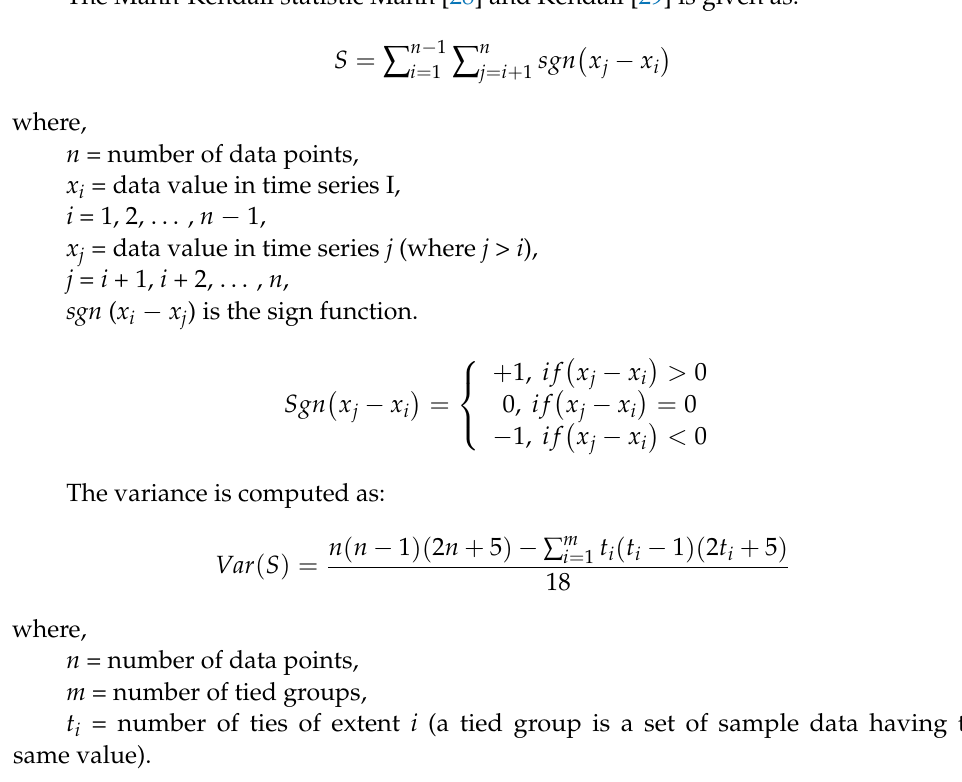
Figure 3. Flow chart of the methodology demonstrating the steps used in this work.